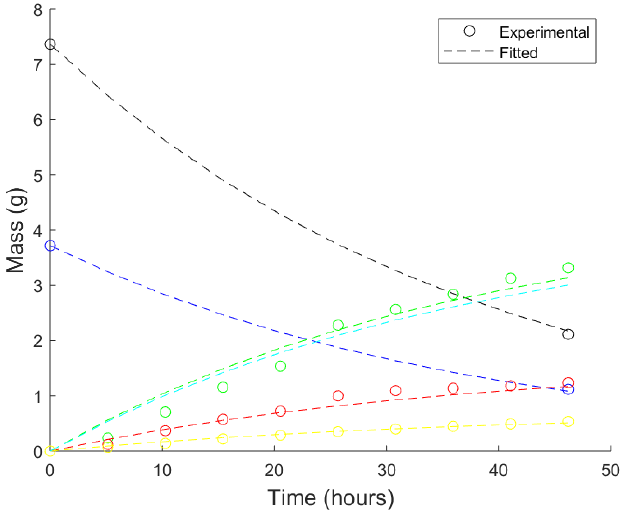
Figure 8. Cumulative production results of experiments (circles) and numerical simulation (dashed lines). Black, kerogen; blue, bitumen; green, heavy oil; red, light oil; yellow, hydrocarbon gas; light blue, char. Table 3. Stoichiometry coefficients and kinetic parameters used for numerical simulation. Reaction